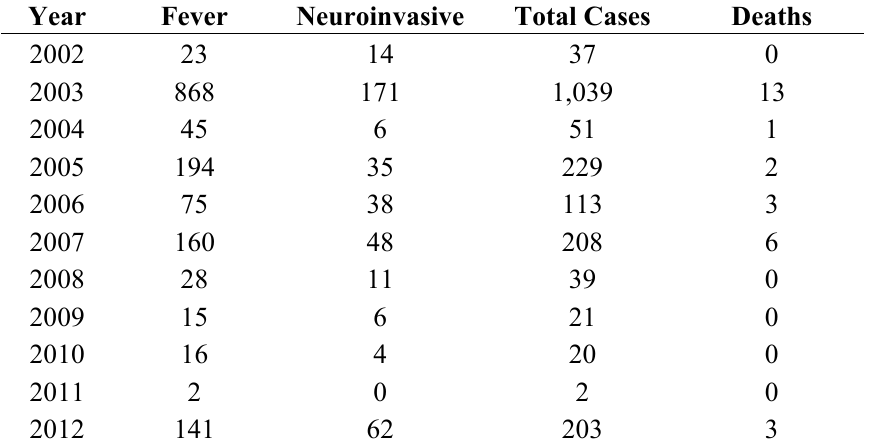
Table 1. Annual cases of human West Nile virus disease in South